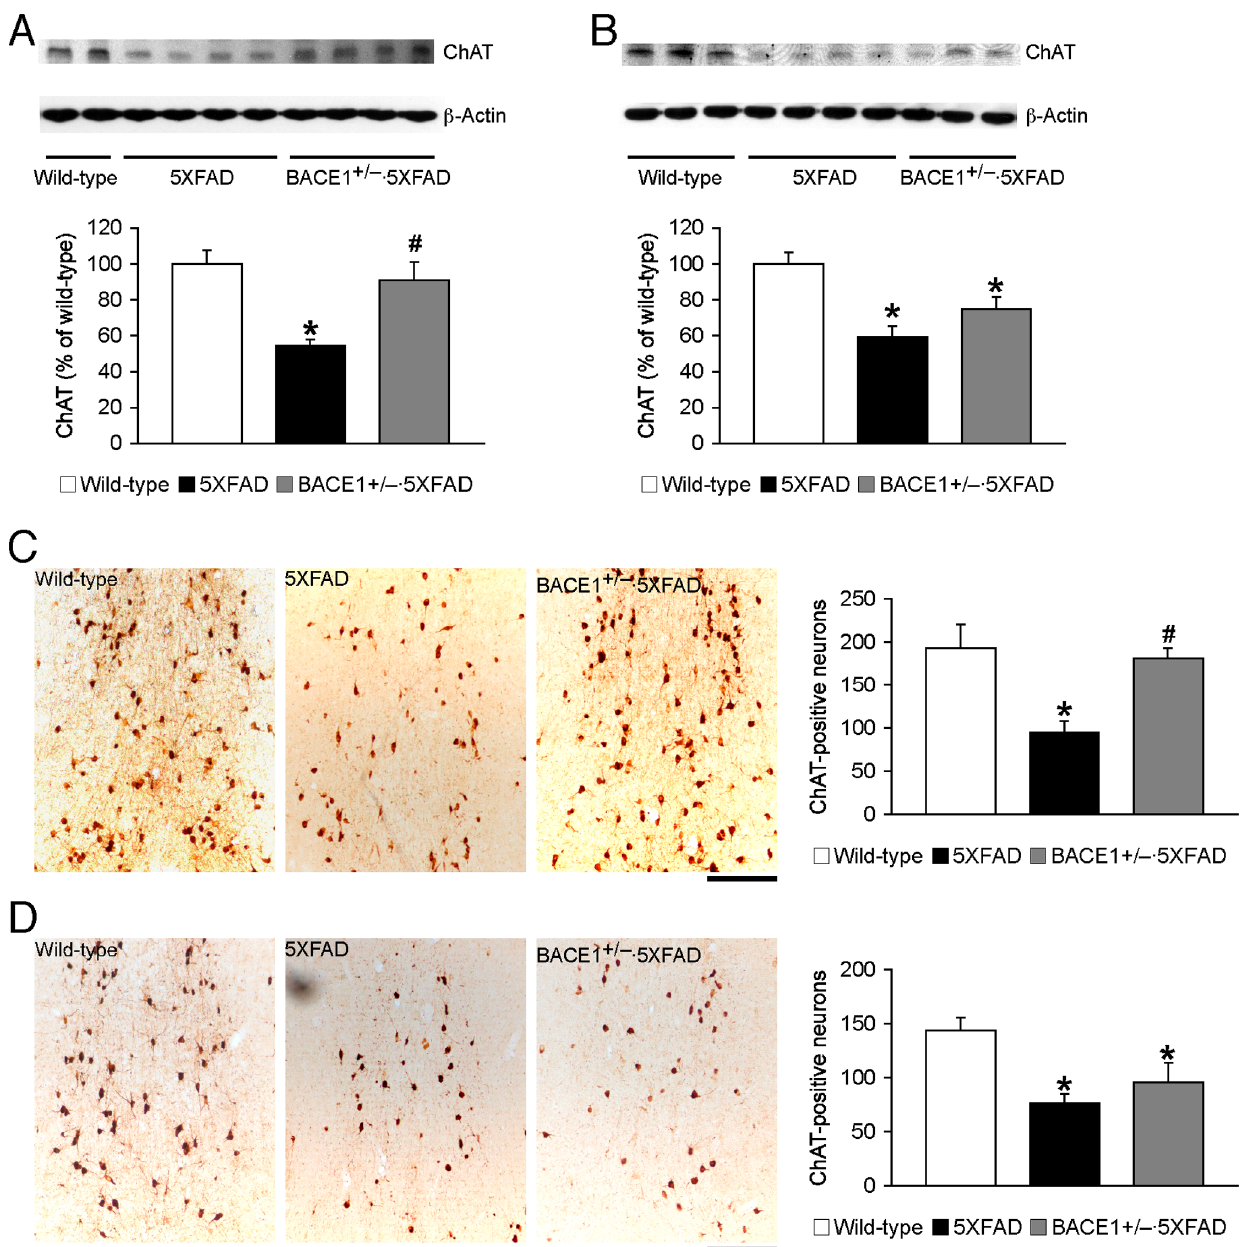
Figure 2. Age-related effects of BACE1 + / 2 deletion on cholinergic neurodegeneration in 5XFAD mice. ( A , B ) Immunoblot analysis of ChAT in hippocampal lysates from wild-type mice and 5XFAD mice with BACE1 + / + or BACE1 + / 2 genotype. Intensities of ChAT-immunoreactive bands of mice at 6 months ( A ) and 15–18 months ( B ) of age were quantified by phosphorimaging and expressed as percentage of wild-type levels ( n =6–9 mice per group). ( C , D ) Brain sections from wild-type mice and 5XFAD mice with BACE1 + / + or BACE1 + / 2 genotype were immunostained for ChAT. Shown are representative photomicrographs of ChAT-immunoreactive neurons in the medial septum of mice at 6 months ( C ) and 15–18 months ( D ) of age. Scale bar =200 m m. The number of ChAT-positive neurons in the medial septum and the vertical limb of the diagonal band (Ch1/2), which provide the cholinergic innervation to the hippocampus, was counted for quantification ( n =4–7 mice per group). Both ChAT measures are significantly reduced in 5XFAD mice irrespective of age as compared with wild-type controls (* p , 0.05). Note that ChAT is restored completely back to wild-type levels in BACE1 + / 2 ? 5XFAD mice at 6 months but not at 15–18 months of age ( # p , 0.05 versus age-matched 5XFAD). All data are presented as mean 6